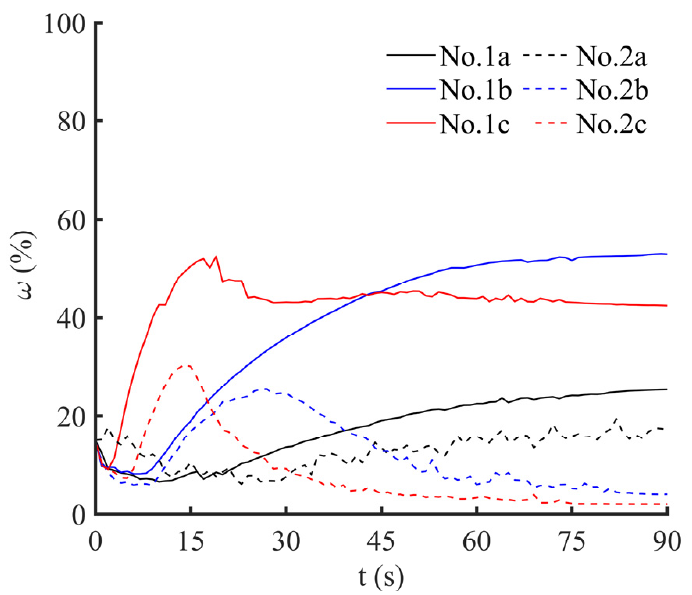
against time. Figure 5. Development of ω 0 − 10 against time. (cid:2868)(cid:2879)(cid:2869)(cid:2868)